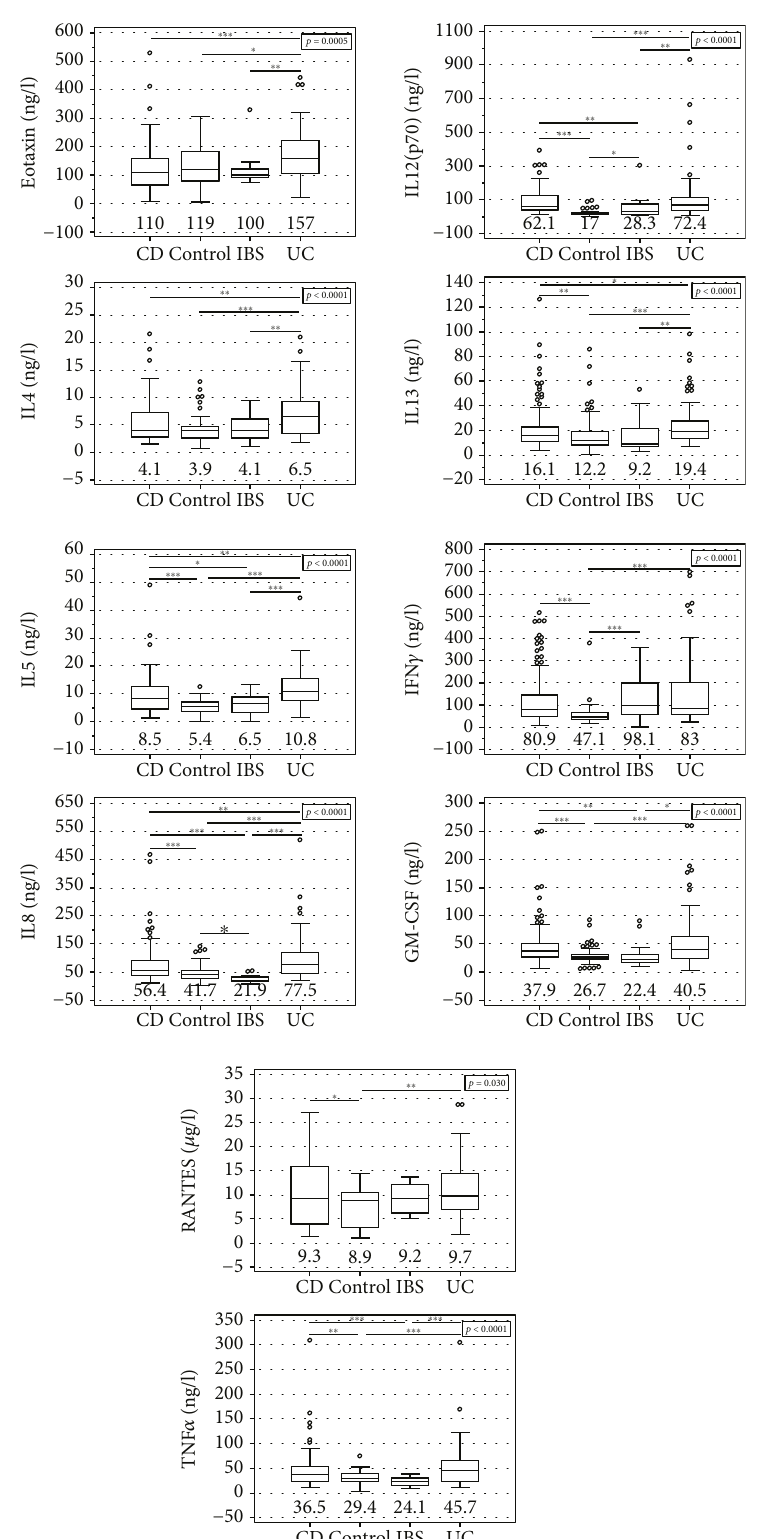
Figure 1: Systemic eosinophil-associated cytokines in patients with in fl ammatory bowel disease or irritable bowel syndrome and healthy controls. Data presented as medians (bar within box) with interquartile range (box) and 91% CI (whiskers) and analyzed with Kruskal-Wallis H test. Open circles mark outlying observations. Horizontal bars with asterisks indicate statistically signi fi cant between-group di ff erences: ∗ p < 0 05 , ∗∗ p < 0 01 , and ∗∗∗ p < 0 001 . CD: Crohn ’ s disease; CONTROL: controls; IBS: irritable bowel syndrome; UC: ulcerative